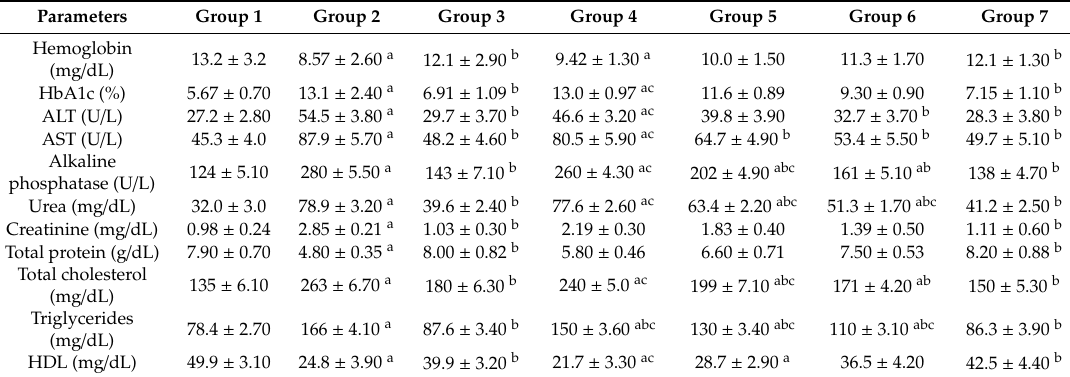
Table 4. E ff ect of methanolic extract of Punica granatum leaves (100, 200, 400, and 600 mg / kg; Groups Table 4. Effect of methanolic extract of Punica granatum leaves (100, 200, 400, and 600 mg/kg; Groups 4–7) on di ff erent biochemical parameters in nicotinamide / streptozotocin-induced type 2 diabetes in 4–7) on different biochemical parameters in nicotinamide/streptozotocin-induced type 2 diabetes in rats.